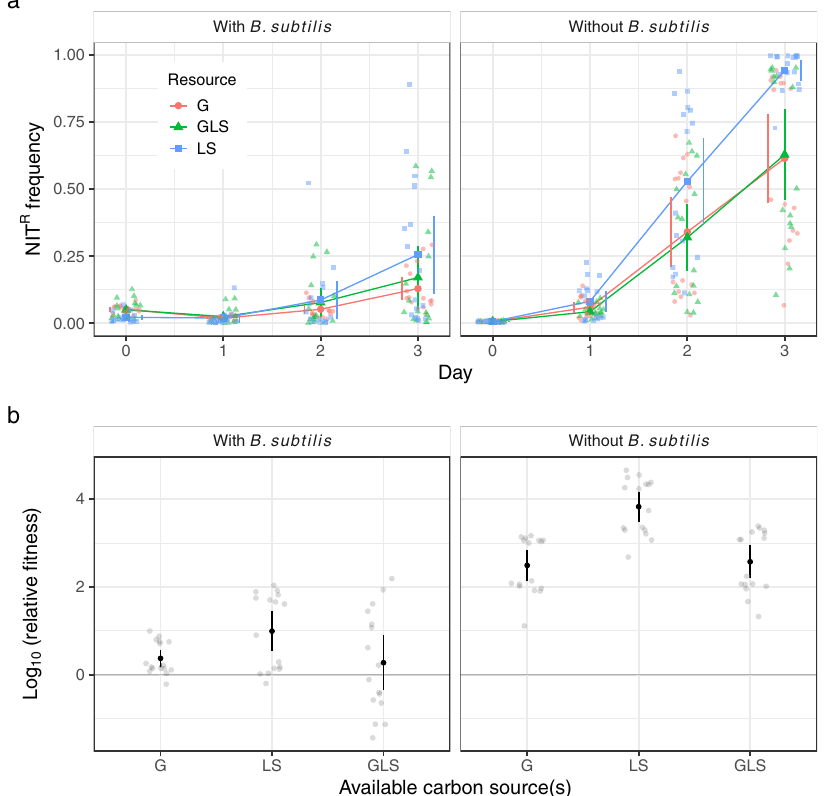
Fig. 2 Resource competition has no effect on NIT resistance dynamics. a Lines depict increases in frequencies of NIT R E. coli cells over 3 days at a quarter of MIC for both panels. Colors depict dynamics at the three available carbon sources in the media (G: 0.2% Glu; LS: 0.2% Lac + 0.3% Salicin; GLS: 0.1% Glu + 0.1% Lac + 0.15% Salicin). b Depiction of log-transformed relative fi tness of NIT R cells in the presence and absence of B. subtilis after 3 days of competition with NIT S cells in the different carbon source regimes. The log-transformed relative fi tness value of zero (gray horizontal line) represents no fi tness advantage to either NIT R or NIT S strains, while positive values indicate an advantage to NIT R strains. Lighter points depict individual replicates, darker points represent means, and error bars represent 95% con fi dence intervals ( t -distribution, n = 16 for both panels).